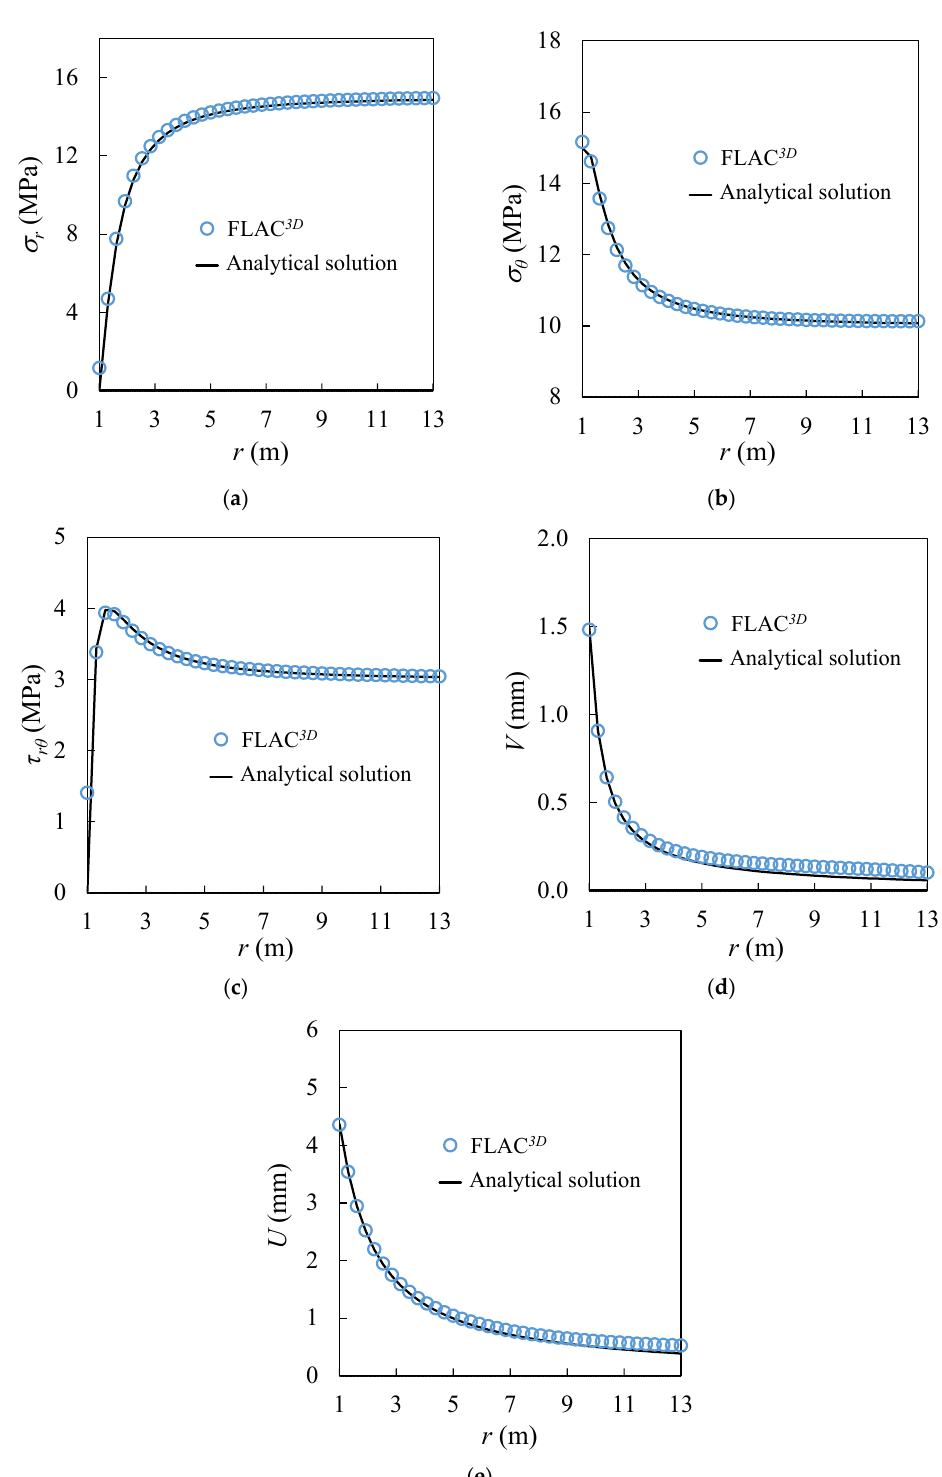
Figure A5. Comparisons between the numerical results and the analytical results of ( a ) σ r , ( b ) σ θ , ( c ) τ r θ , ( d ) V , ( e ) U long x ‐ axis around a cylinder hole in the linearly elastic material.